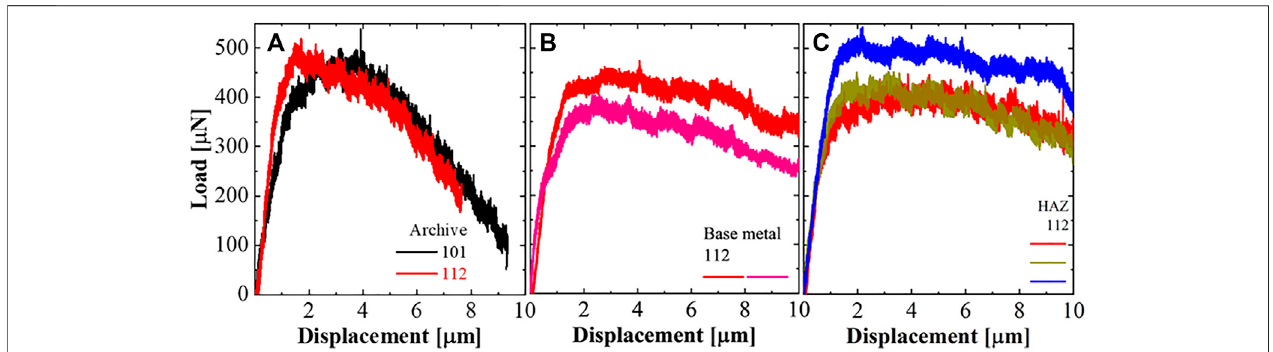
Frontiers in Materials |